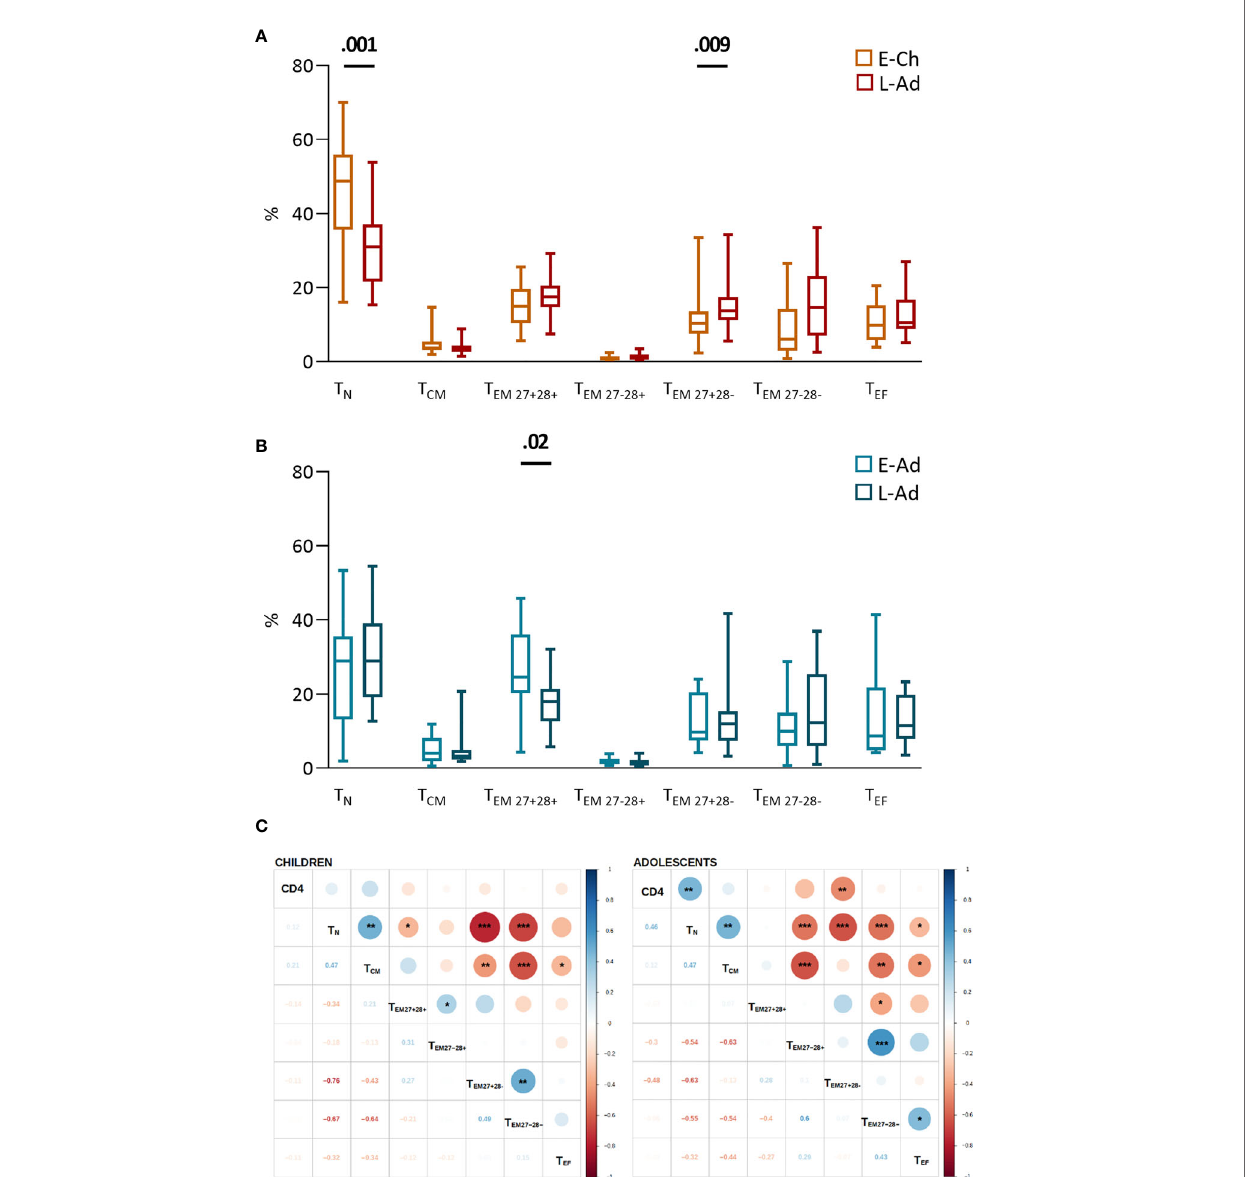
FIGURE 3 | CD8 T-cell differentiation subsets in patients with early and late treatment initiation. T-cell phenotypes were assessed by fl ow cytometry on fresh whole blood ( Supplementary Material ). The percentage of each subset among total CD8 T lymphocytes is presented for children (A) and adolescents (B) on box and whiskers plots showing the minimum and maximum values. Early and late treatment groups were compared in Mann-Whitney tests; when signi fi cant, P values are shown on the graph. Subsets are presented from the least to the most differentiated, and were de fi ned as naive T N (CD45RA + CCR7 + ); central memory T CM (CD45RA - CCR7 + ); effector memory T EM27+28+ (CD45RA - CCR7 - CD27 + CD28 + ); T EM27-28+ (CD45RA - CCR7 - CD27 - CD28 + ); T EM27+28- (CD45RA - CCR7 - CD27 + CD28 - ); T EM27-28- (CD45RA - CCR7 - CD27 - CD28 - ) and effector T EF (CD45RA + CCR7 - CD27 - CD28-) cells. (C) The correlograms present Spearman ’ s rank correlation coef fi cients as symbols (upper quadrants) and values. Signi fi cant associations are indicated by symbols (* p < .05; ** p < .01; *** p < .001). CD4 T-cell counts were used to calculate